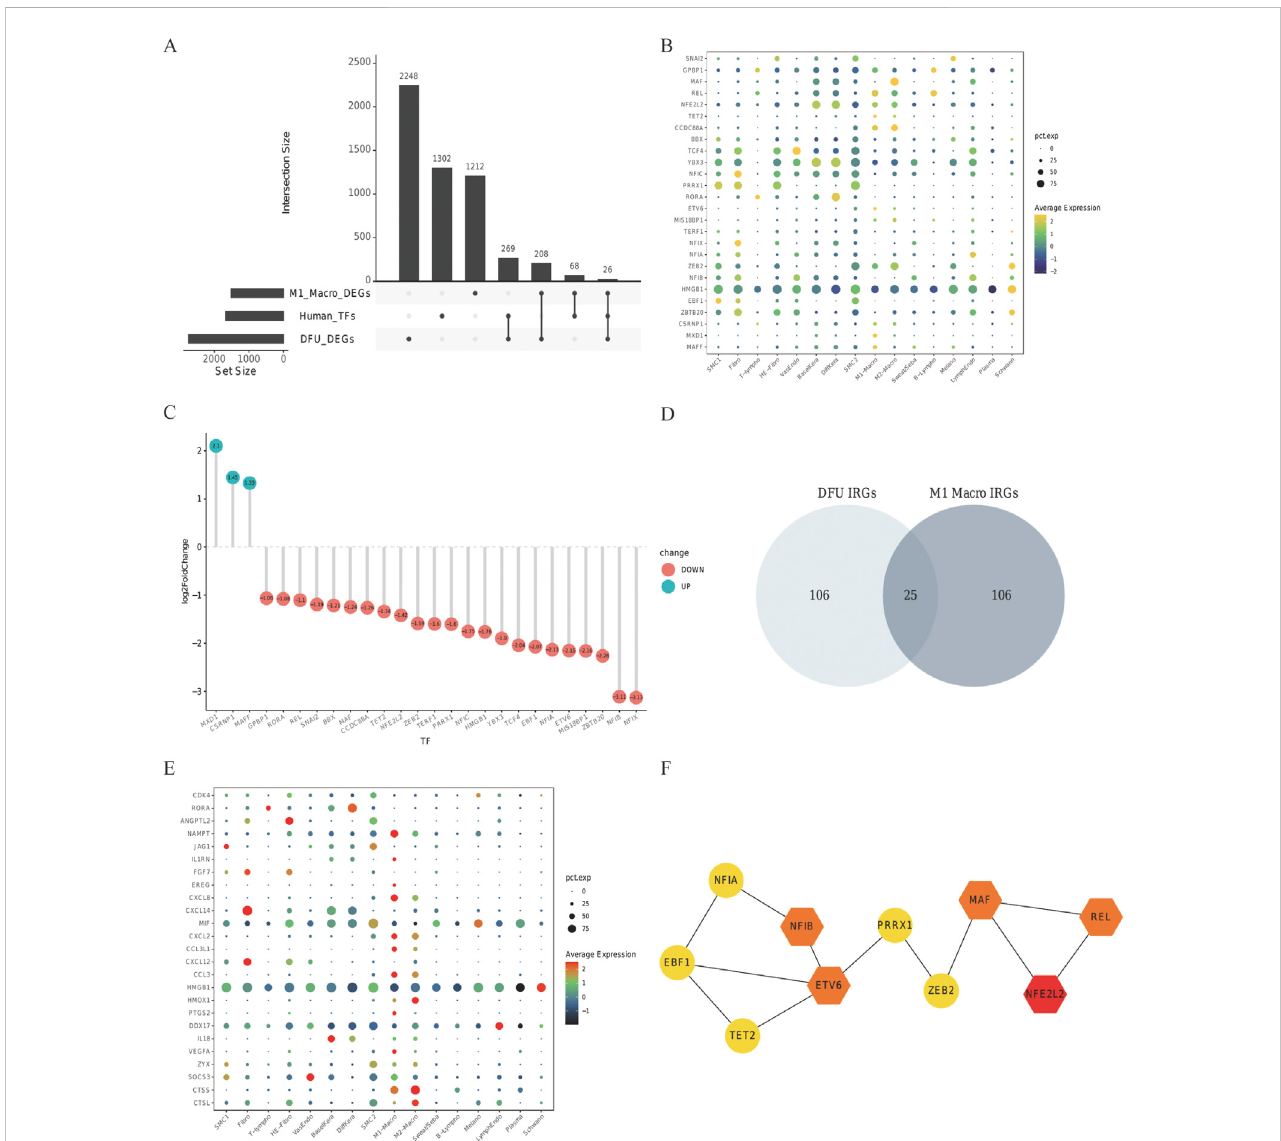
FIGURE 5 Relevant regulatory transcription factors and common IRGs. In the (A) upset plot, TFs in DFU in DEG of GES80178 and TFs in the M1 macrophage cluster from GSE165816, Human TF database, were shown. (B) GSE165816 ’ s 26 TF expression levels. Common TF expression in the DEG of GES80178. (C) Green indicates up-regulated TFs, whereas red indicates down-regulated TFs. (D) DFU IRG and M1-Macro IRG Venn diagrams. The expression of shared IRGs betweenDFUandM1-MacroIRGsisshownin (E) . (F) STRING-illustratedPPInetworkofthecommonTFs.NFE2L2,REL,ETV6,MAF,andNF1Bareusedas hub